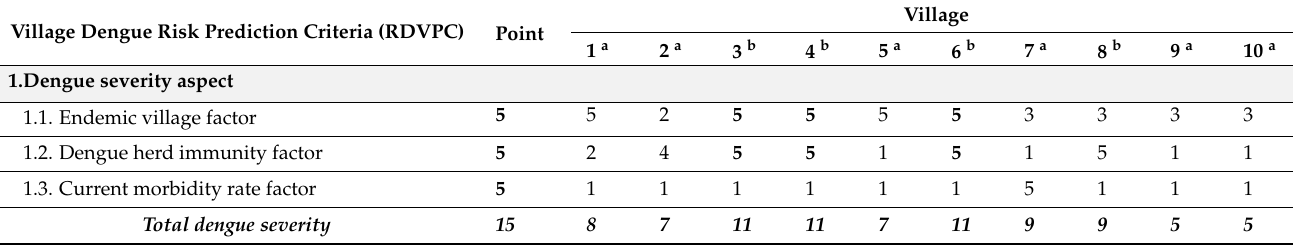
Table 3. Villages with high and low risk of dengue in the Keawsan